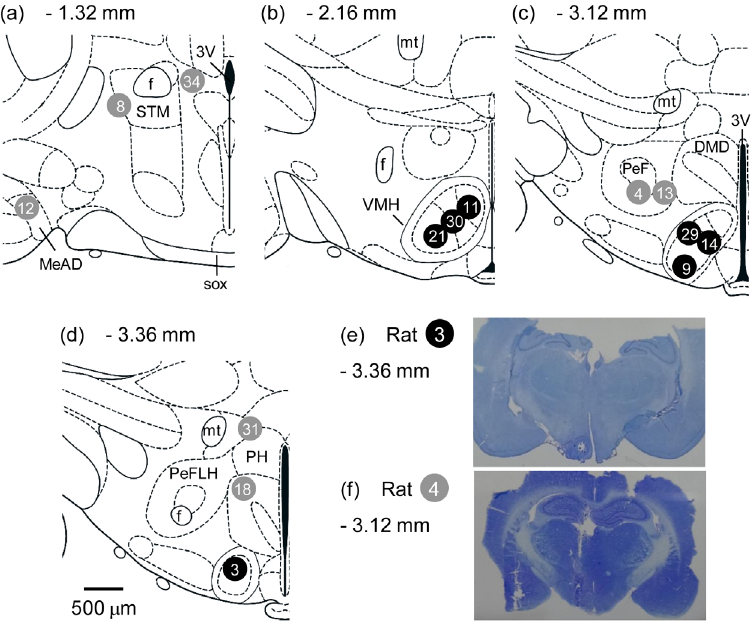
Figure 2. Coronal sections taken from the Paxinos and Watson atlas (2007) showing the location of the thermistor tips (panels A– D). The numbers above the schematic representation of each hypothalamic section indicate the distance (in mm) between the section plane and the bregma. Legends: 3V, 3rd ventricle; DMD, dorsomedial hypothalamic nucleus, dorsal part; f, fornix; MeAD, medial amygdaloid nucleus, anterodorsal part; mt, mammillothalamic tract; PeF, perifornical nucleus; PeFLH, perifornical part of lateral hypothalamus; PH, posterior hypothalamus; sox, supraoptic decussation; STM, bed nucleus of the stria terminalis, medial division; VMH, ventromedial hypothalamus nucleus. Photomicrographs of coronal sections (50 m m, cresyl violet staining) showing the location of the thermistor tips in two rats: one rat had a thermistor inserted into the frontal cortex, and the another animal had a thermistor inserted into the caudate putamen nucleus (panels E and F).